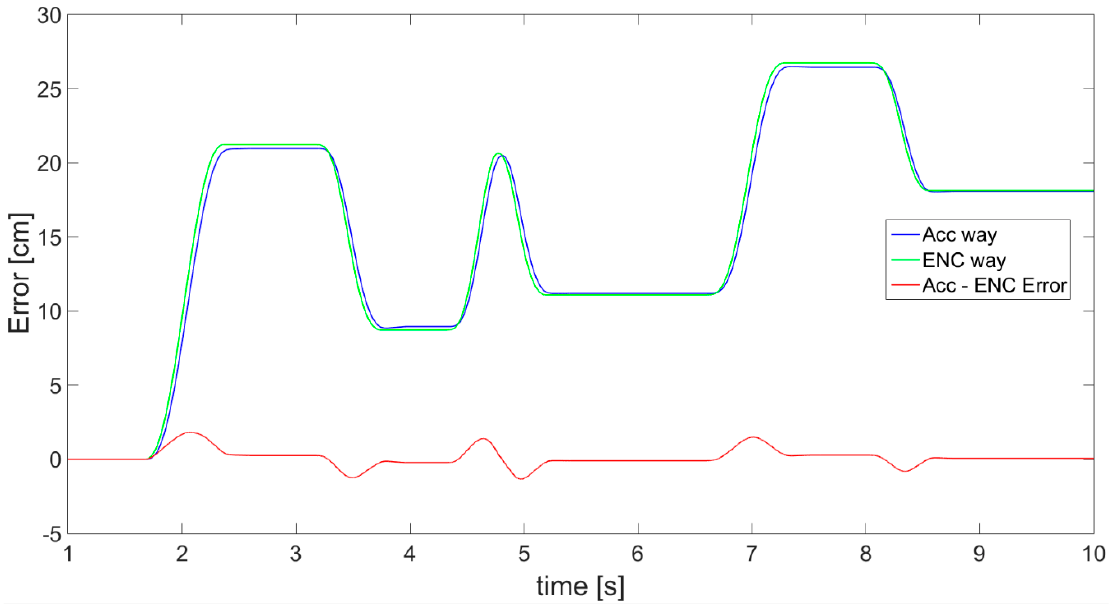
Figure 20. Results of displacement: estimated with accelerometer (blue), measured with encoder (green), and calculated difference between them (red). Sensors 2020 , 20 , x FOR PEER REVIEW